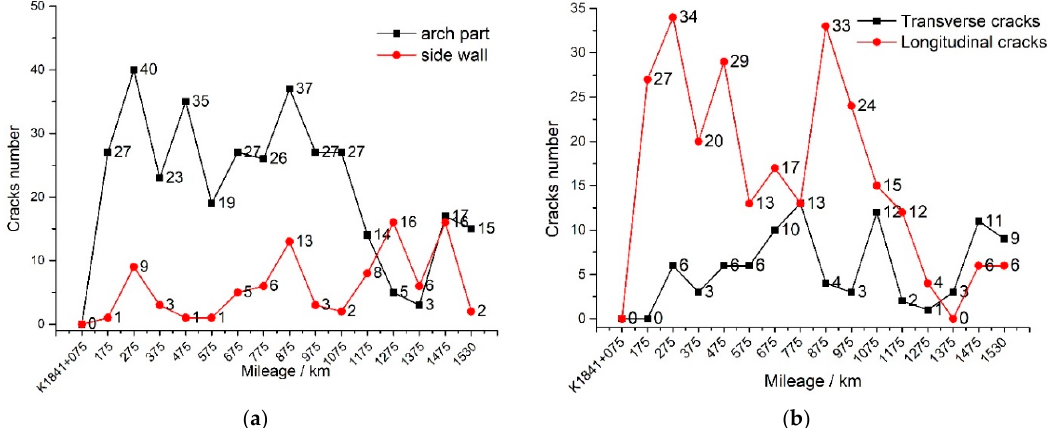
Figure 8. Statistical graphs of lining cracks number (accumulation per 100 m): ( a ) cracks in arch part and side wall; ( b ) transverse and longitudinal cracks. Appl. Sci. 2020 , 10 , x FOR PEER REVIEW